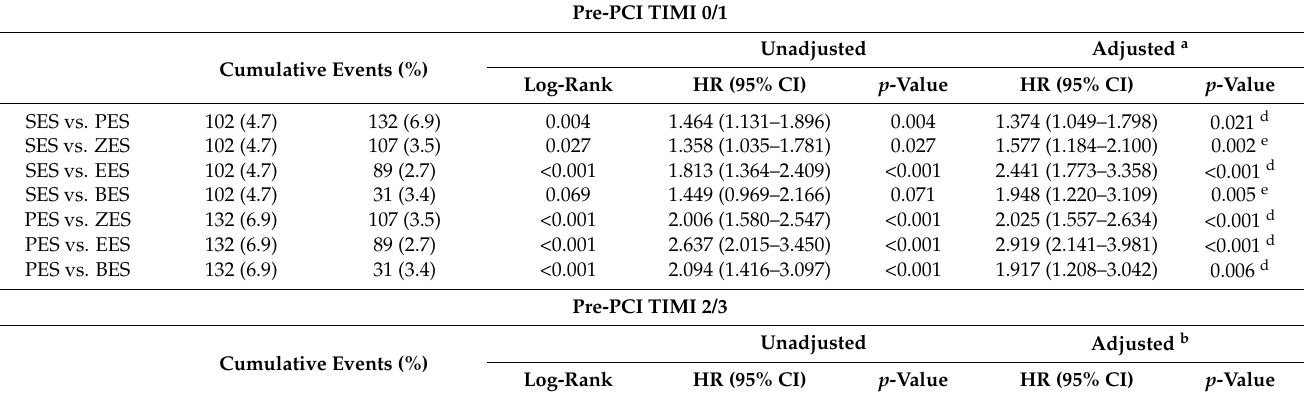
Table 4. Clinical outcomes by Kaplan–Meier analysis and Cox-proportional hazard ratio analysis according to types of deployed stents.